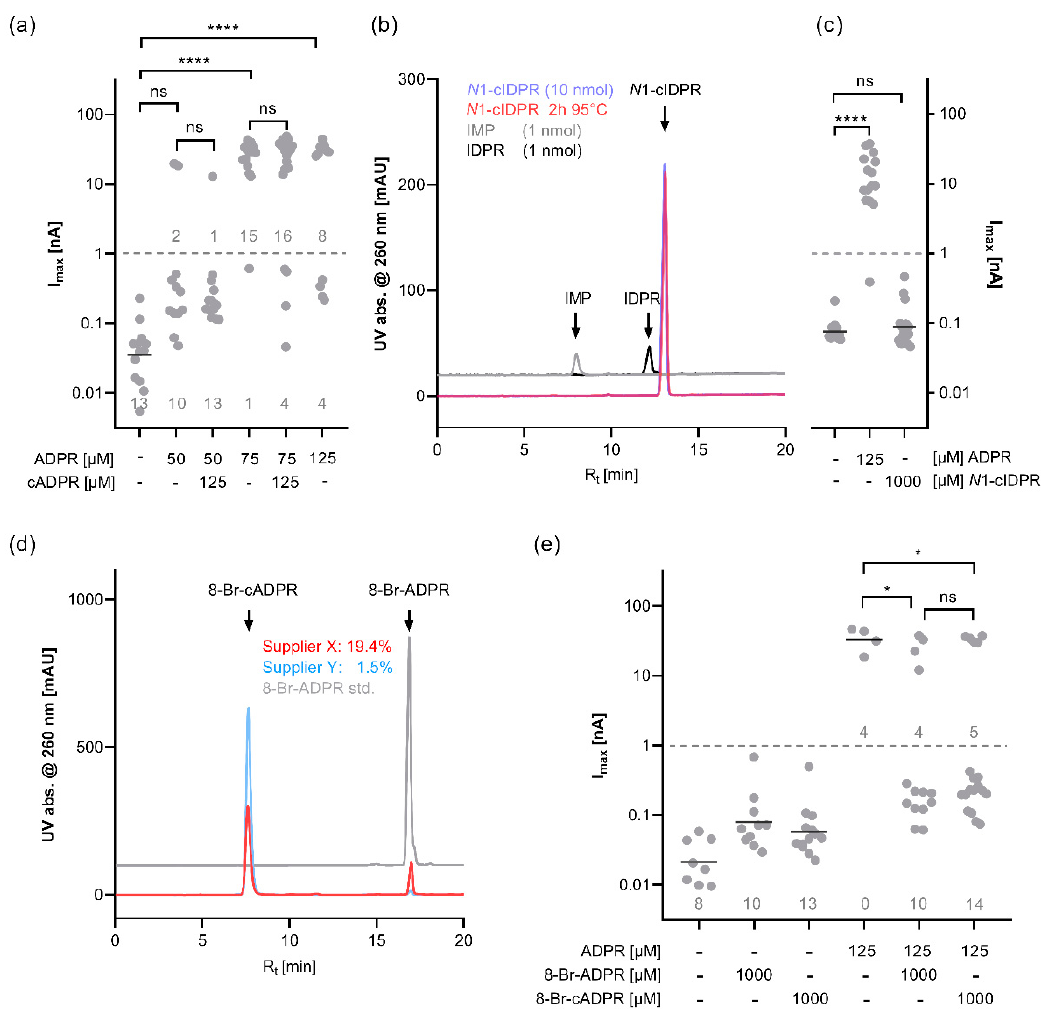
Figure 2. ( a ) cADPR does not enhance the TRPM2 current at threshold concentrations of ADPR. HEK293 cells with stable expression of human TRPM2 were infused via the patch pipette with an intracellular solution with weak Ca 2+ buffering (100 µ M EGTA) and containing varying concentrations of ADPR with or without 125 µ M cADPR. During the recording, cells were kept at room temperature. With ADPR in the pipette solution, the currents show a bimodal distribution, with some cells showing a slight increase in current compared with the control while others exhibit a current two orders of magnitude higher. Log-transformed data were tested using Kruskal–Wallis test with Dunn’s correction (**** adj. p < 0.0001, ns = not significant) ( b ) HPLC analysis of N 1-cIDPR (blue), N 1-cIDPR that has been incubated at 95 ◦ C for 2 h (red), and standards of potential breakdown products IMP (grey) and IDPR (black). ( c ) The nonhydrolysable cADPR analogue N 1-cIDPR does not activate human TRPM2. TRPM2-expressing HEK293 cells were infused with a pipette solution containing either no nucleotide or either ADPR or N 1-cIDPR. Log-transformed data were tested using Kruskal–Wallis test with Dunn’s correction (**** adj. p <0.0001, ns = not significant) ( d ) HPLC analysis of 8-Br-cADPR from two different suppliers (red and blue) and an 8-Br-ADPR standard (grey). The numbers indicate the fractional peak area of the 8-Br-ADPR peak in the analysed 8-Br-cADPR. ( e ) 8-Br-ADPR and 8-Br-cADPR reduce the ADPR-induced current in TRPM2-expressing HEK293 cells. Cells were infused with a pipette solution that contained no nucleotide, 125 µ M ADPR, 1 mM 8-Br-ADPR, 1 mM 8-Br-cADPR, or a combination thereof. For some conditions, the horizontal bar indicates the mean of the log-transformed currents. Due to the bimodal distribution, the fraction of cells responding to a current above and below 1 nA were compared using Fisher’s exact test (* p < 0.05, ns = not